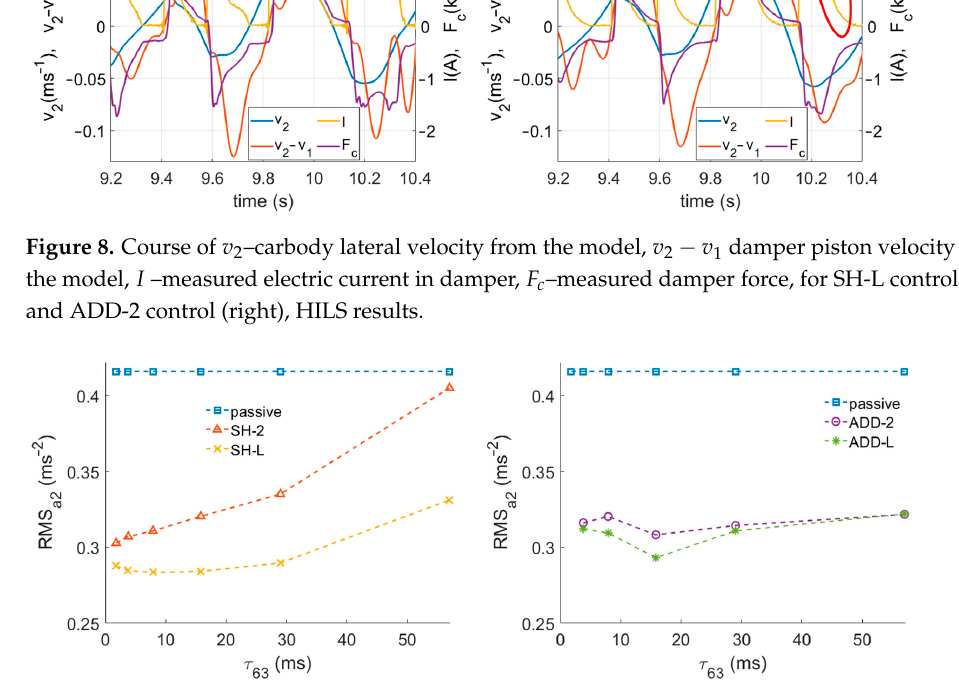
Figure 9. Damper force drop response time τ 63 effect for passive mode, SH-2 and SH-L algorithms ( left ) and passive mode, ADD-2 and ADD-L algorithms ( right ), HILS results.